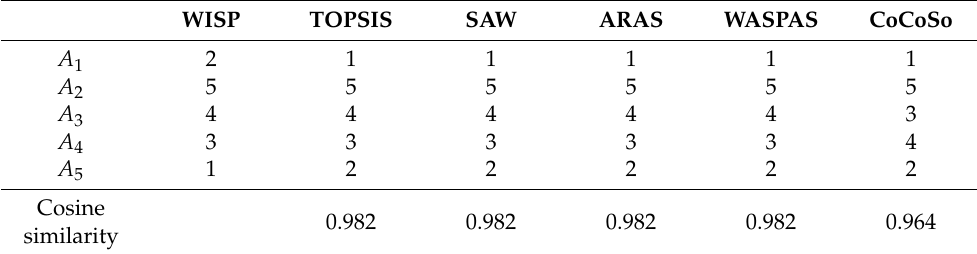
Table 7. The ranking orders obtained on the basis of the second decision-making matrices. WISP TOPSIS SAW ARAS